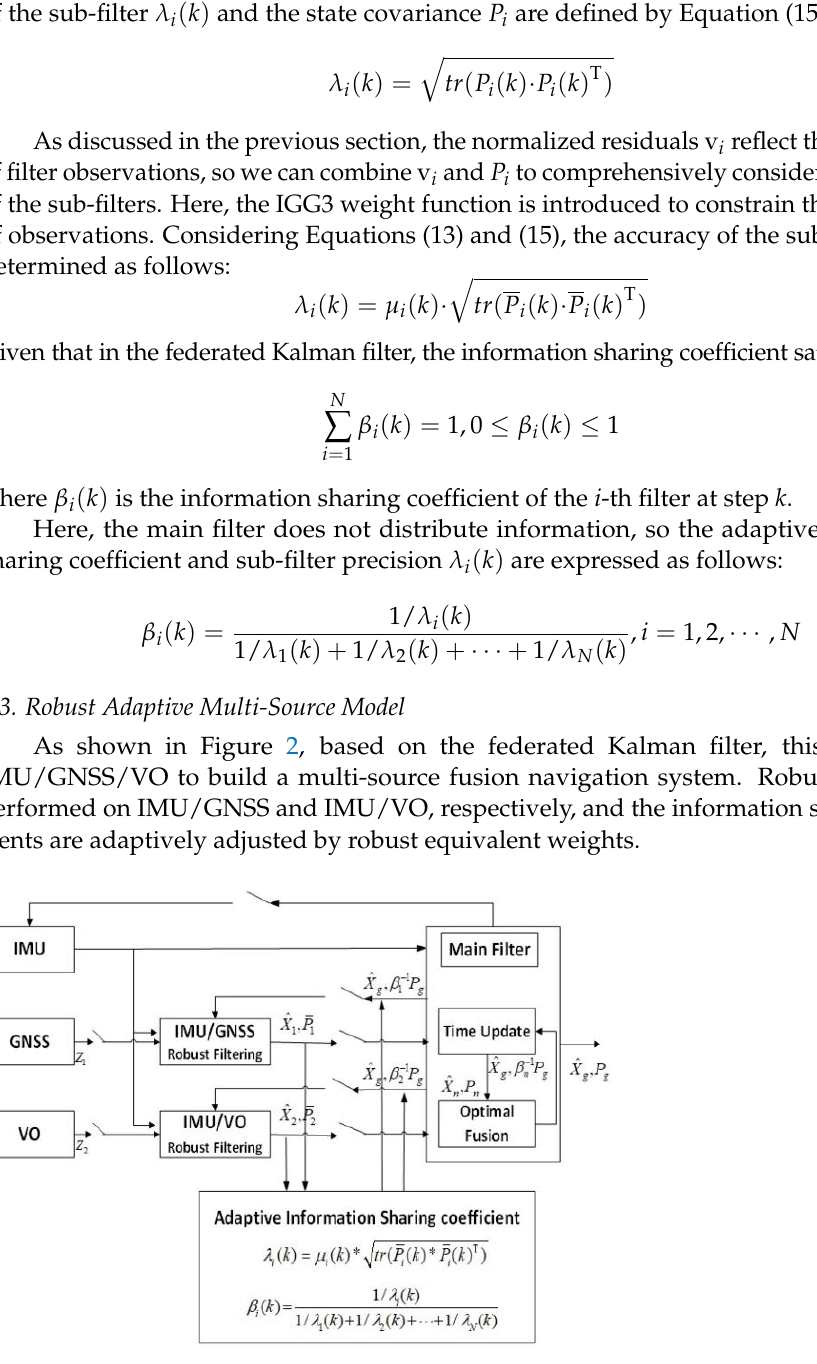
Figure 2. Robust adaptive multi-source model.